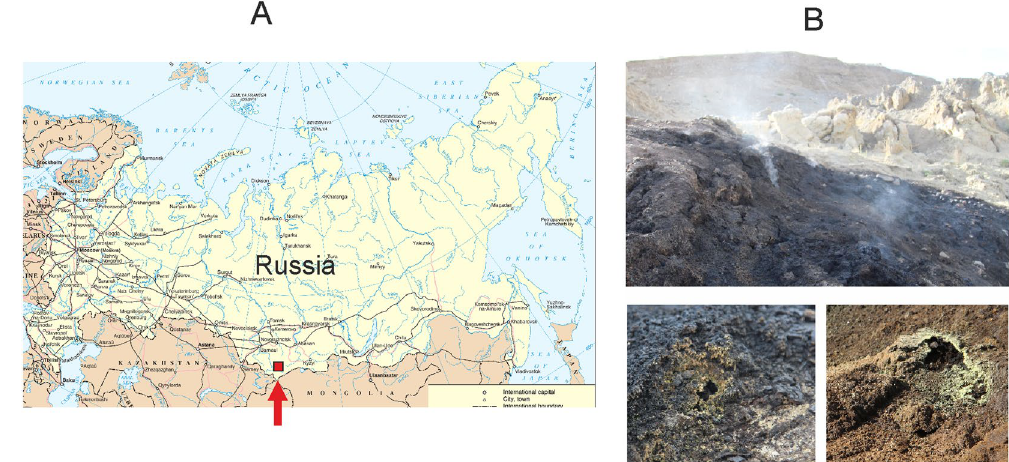
Figure 1. The site of underground combustion of brown coal studied in the work. ( A ) Location map. The red rectangle shows the location of the study area. The map was derived from a United Nations map (https:// commons.wikimedia.org/wiki/File:Un-russia.png) which is in the public domain. ( B ) General view of the area where coal combustion occurs. The bottom part shows the fumarole-like structures. The images were taken by the